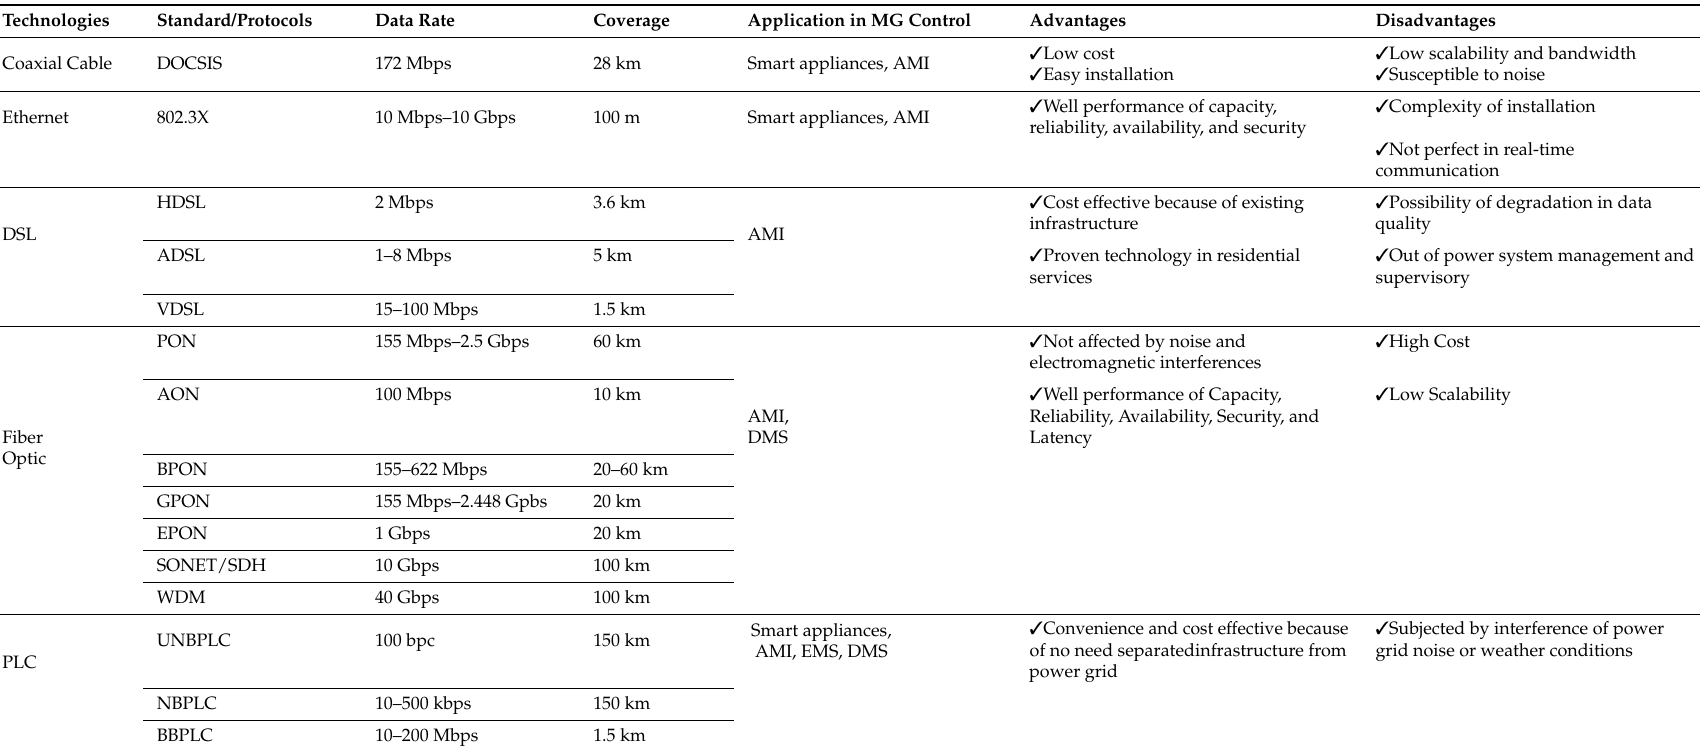
Table 4. Wired technologies specification and application in MG communication